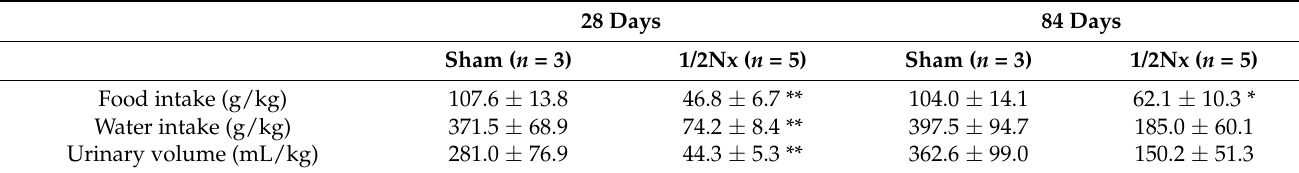
Table 2. Food intake, water intake, and urinary volume of Sham operated and 1/2Nx DEK rats.